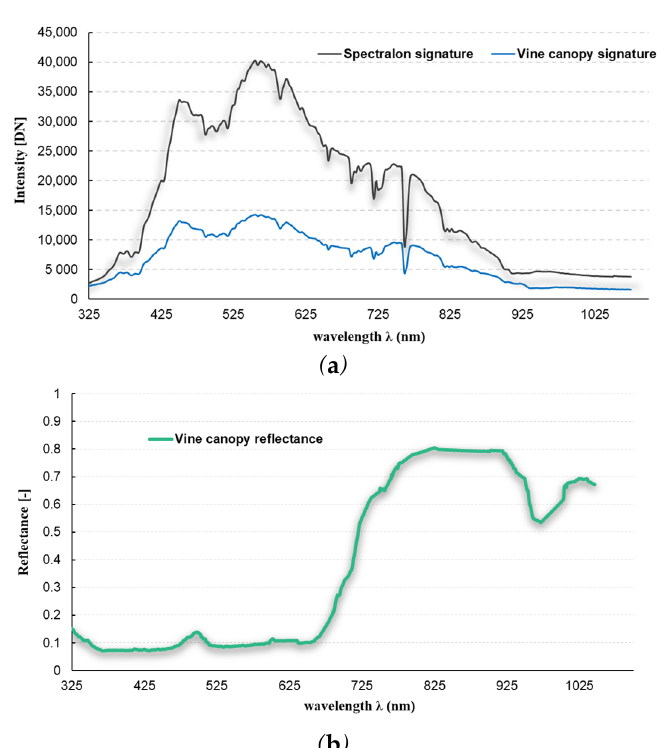
Figure 5. ( a ) Hyperspectral reflectance data (digital number) of Spectralon panel and vine; ( b ) Conversion of raw DN values to vine canopy reflectance with the ASD field